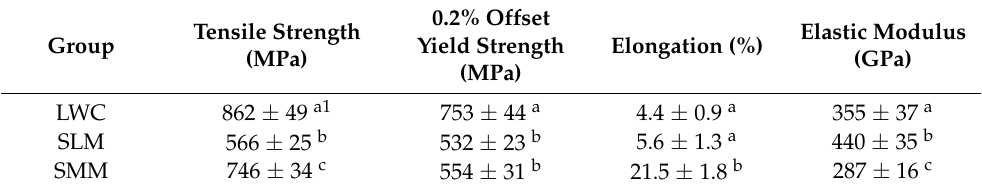
Table 1. Mechanical properties of three Ni–Cr–Mo alloys produced using three different manufactur- ing techniques ( n =